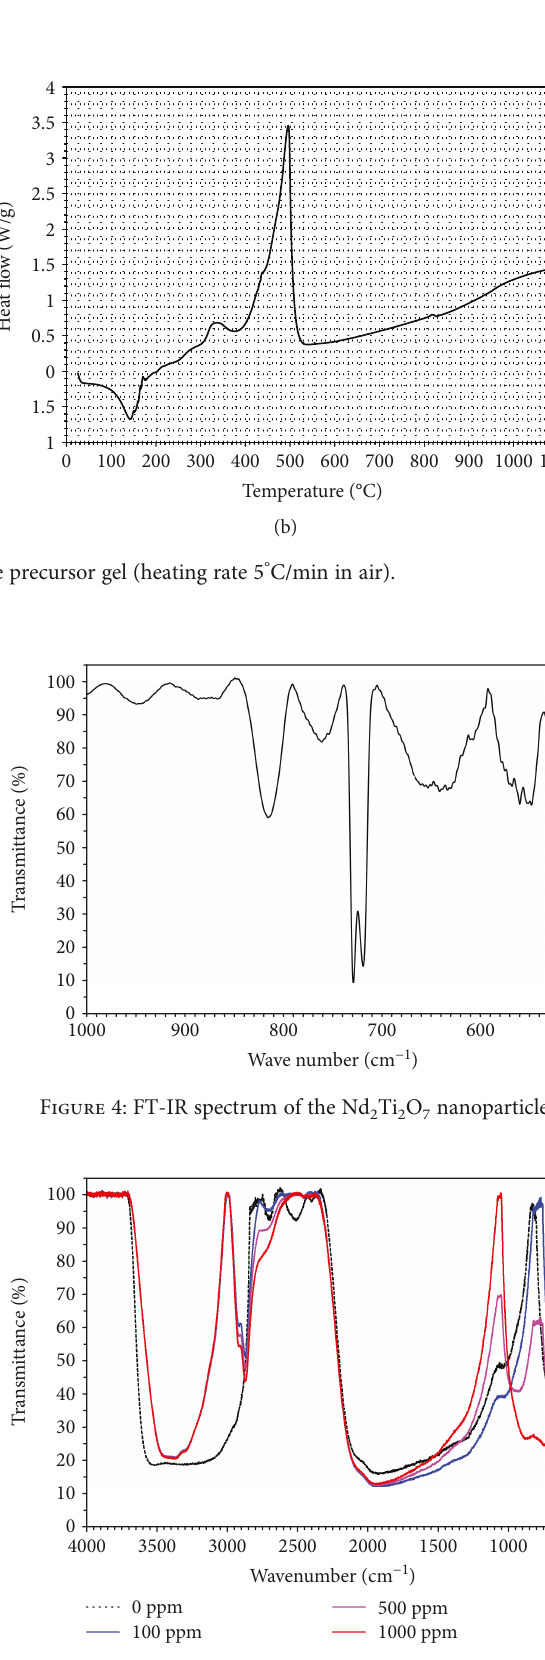
Figure 5: FT-IR spectra of chitosan fi lms doped with